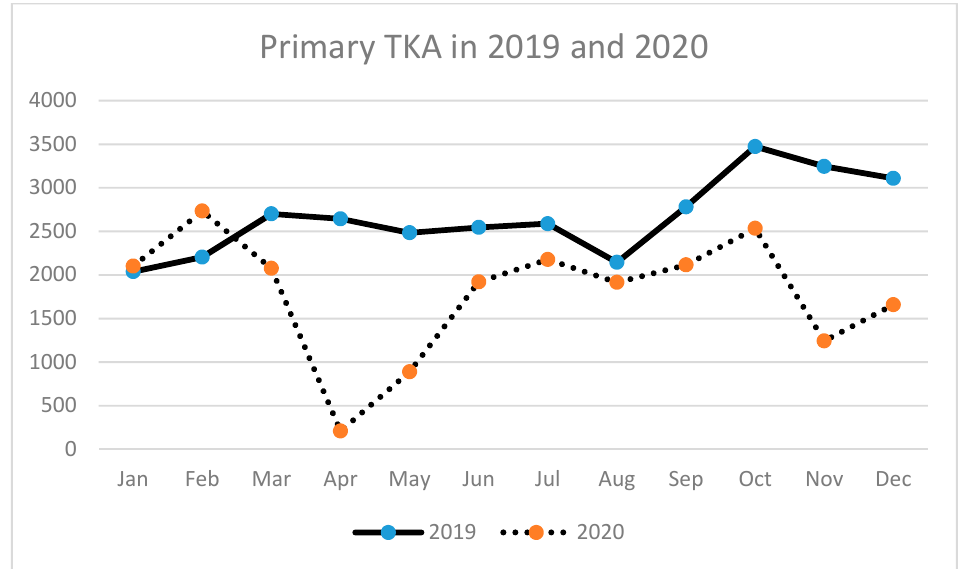
Figure 5. Number of total knee arthroplasties (TKA) performed in the particular months of 2019 and 2020 in Poland.